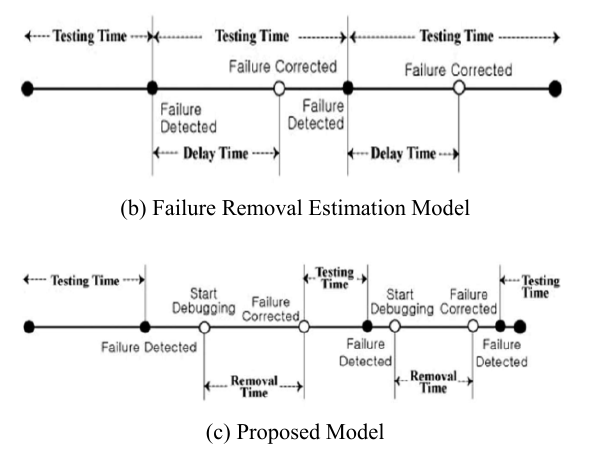
Fig. 2. Testing Time, Delay Time and Removal Time of each model